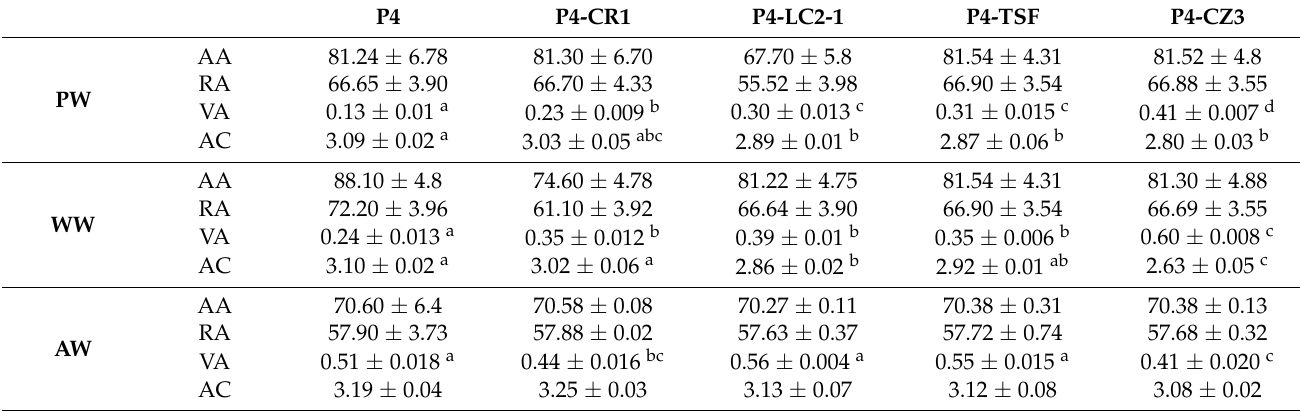
Table 2. Main analytical characteristics of the experimental beers produced by pure (P4) and mixed cultures (P4-CR1, P4-LC2-1, P4-TSF, P4-CZ3) in the three different worts (PW, WW and AW). For each parameter and each wort, data with different superscript letters mean significant differences (Tukey’s test; p ≤ 0.05) between beers produced by the single and mixed